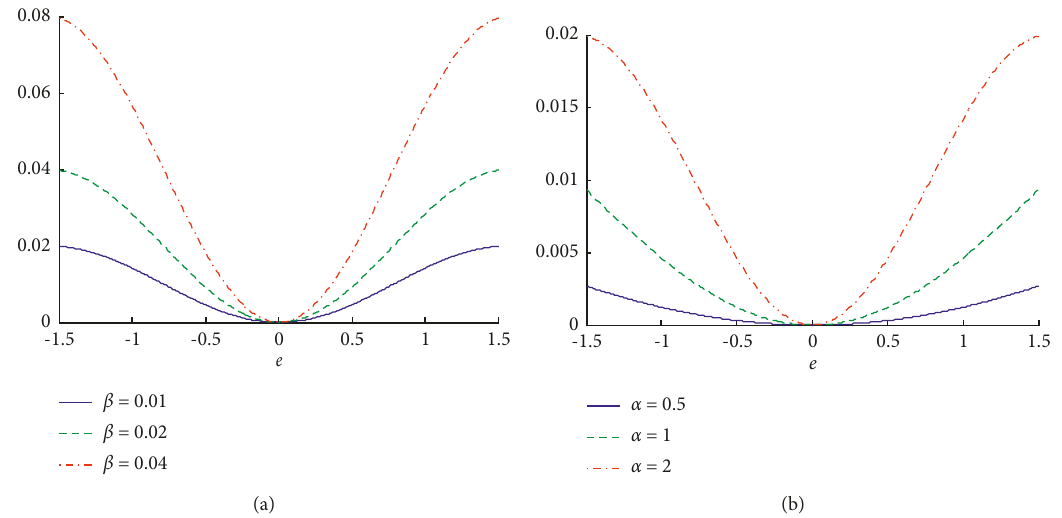
Figure 4: Function relationship between μ ( k ) and e ( k ) . (a) α � 2 and β � 0.01, 0.02, 0.04. (b) β � 0.01 and α � 0.5, 1,